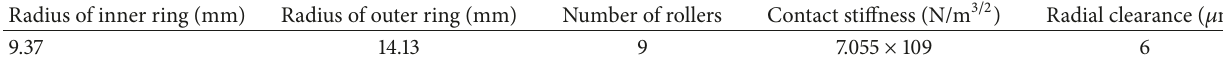
Table 3: Parameters of the intermediate bearing.